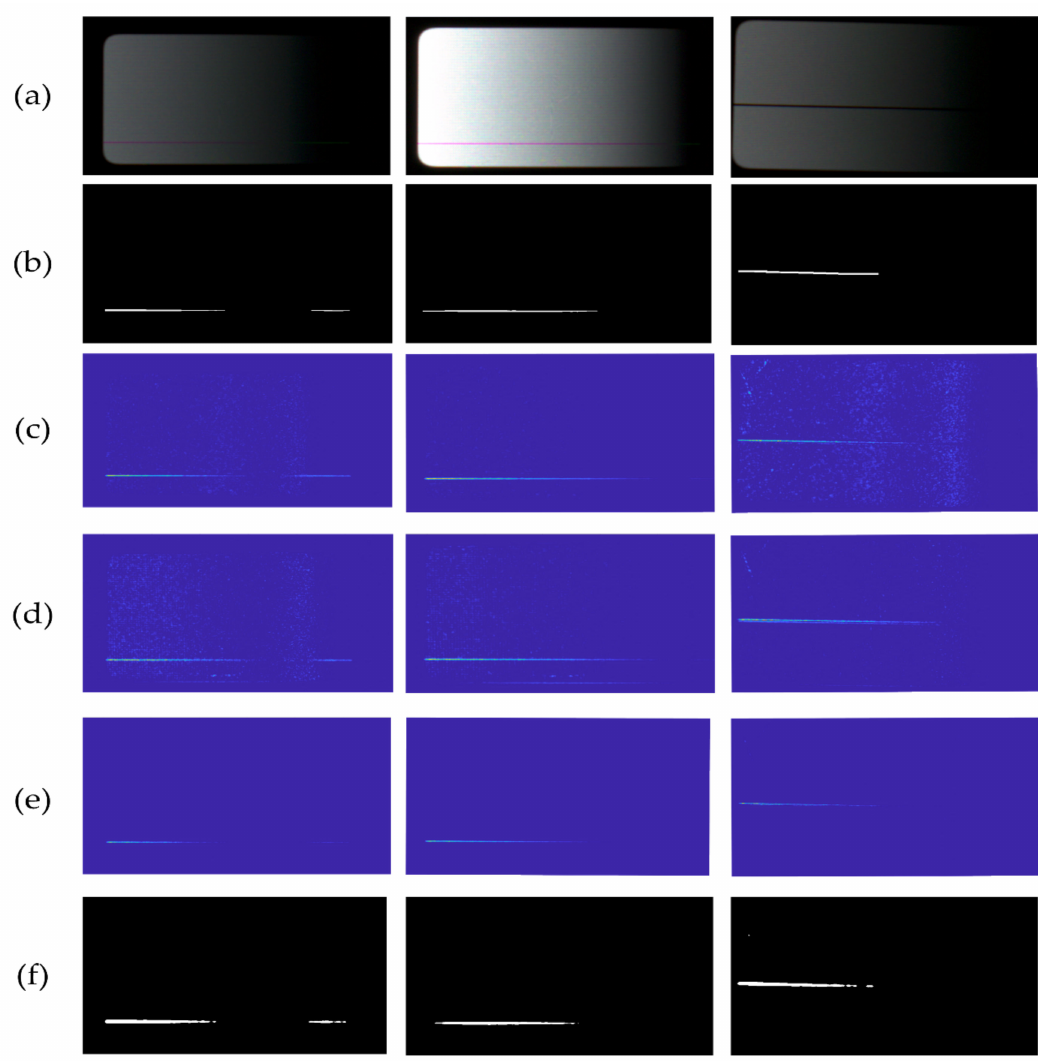
Figure 5. Change defect feature detection results. ( a ) original image; ( b ) GT map; ( c ) red-green fusion feature map; ( d ) blue-yellow fusion feature map; ( e ) color fusion saliency map; ( f ) threshold segmentation result map.